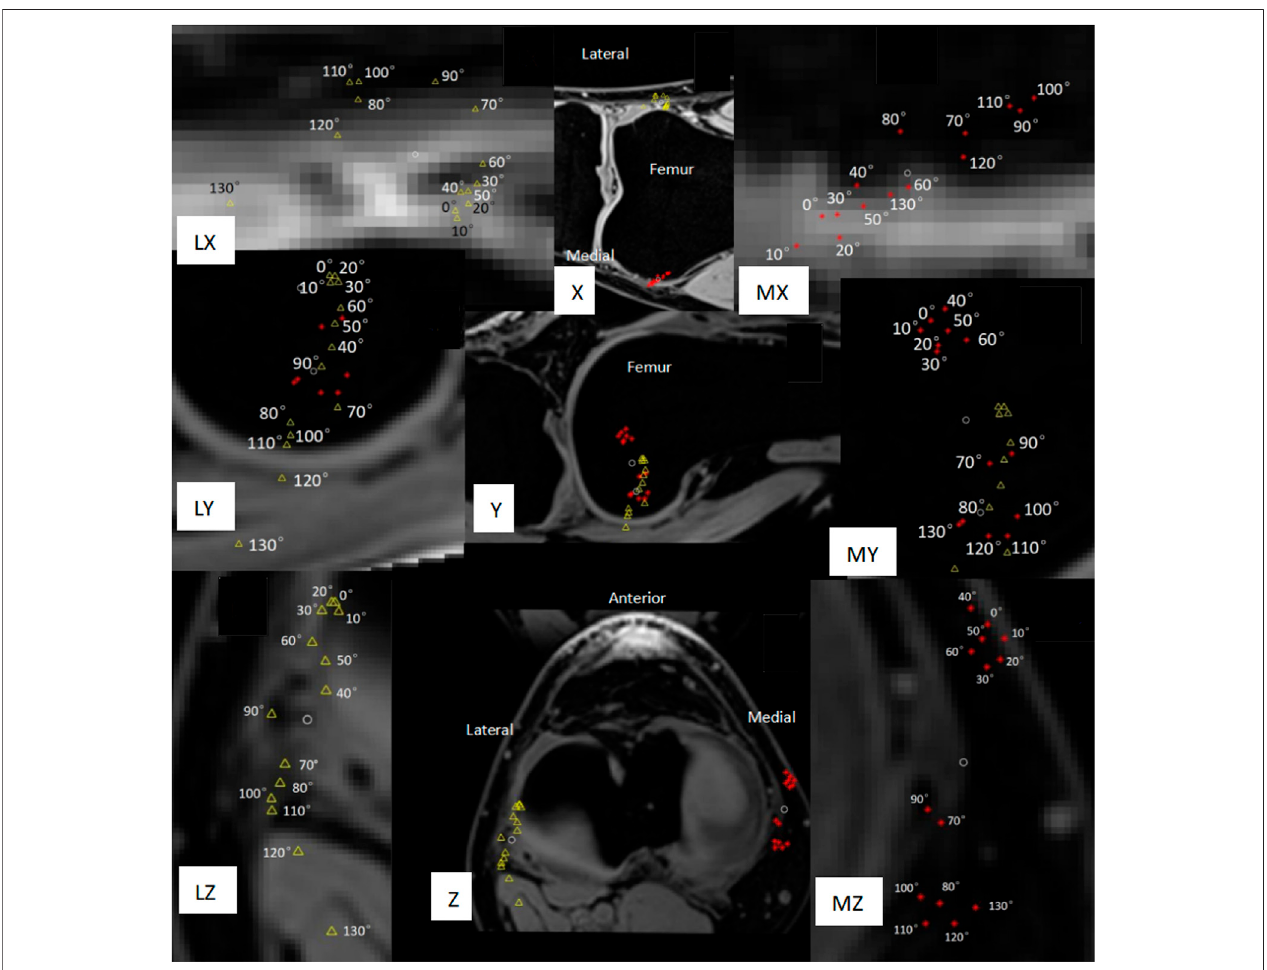
FIGURE 6 | Movement trajectory of the medial/lateral condyle of the femur with the tibia as a fi xed rigid body. The red asterisk represents the medial condyle, the yellow triangle represents the lateral condyle, and the two white circles represent the average position of the movement trajectory of the medial condyle and the lateral condyle, respectively. PC is the standard deviation of the distance between the white circle and each red asterisk/yellow triangle around it. (X) Coronal plane. (Y) Sagittal plane. (Z) Horizontal plane. (MX, MY, MZ) Local magni fi cation of the movement trajectory of the femoral medial condyle. (LX, LY, LZ) Local enlargement of the movementtrajectoryofthefemorallateralcondyle.(Z,LZ,MZ)Thereversescrewhomephenomenonatthe fl exionof40 ° – 70 ° andscrewhomeof fl exionover70 ° should be